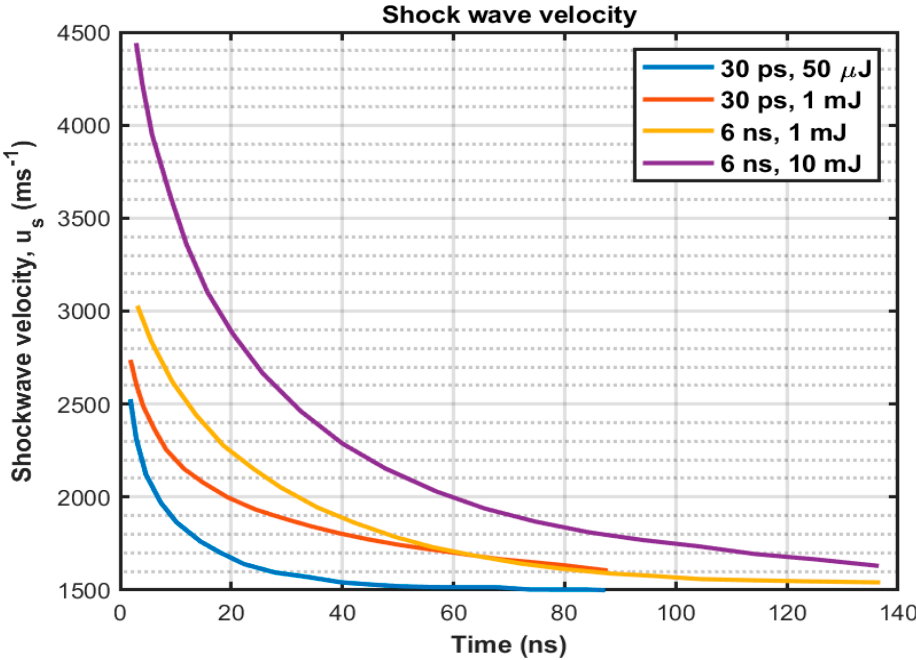
Figure 4. Experimentally determined shockwave velocity for 6 ns and 30 ps pulse duration, redrawn from [63].